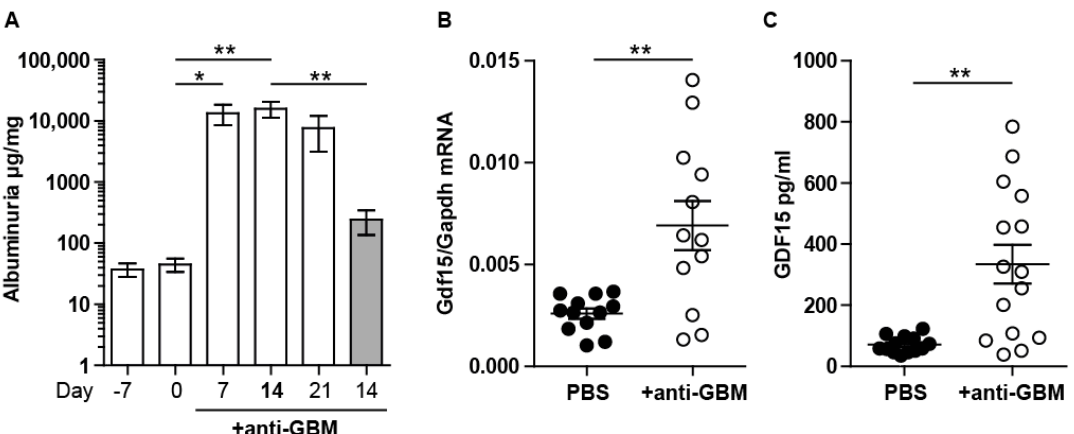
Figure 1. Evaluation of the anti-GBM model and expression of GDF15. ( A ) We used the commercially available GBM antiserum that was raised in sheep against rat GBM. We first examined its nephritogenic potential in C57BL / 6 mice by assessing albuminuria 7, 14, and 21 days after a single intravenous injection of antiserum in pre-immunized mice, as well as in mice without pre-immunization (gray bar, 14 days). ( n = 5, one-way ANOVA). ( B ) Total RNA isolated from kidneys of saline- or antiserum-injected C57BL / 6 mice underwent quantitative real-time RT-PCR analysis and revealed significantly higher expression of Gdf15 in treated mice. ( C ) Serum GDF15 level was significantly increased in antiserum-injected C57BL / 6 mice ( n = 12, Student’s t -Test). Data are mean ± SEM. * p < 0.05; ** p < 0.01.